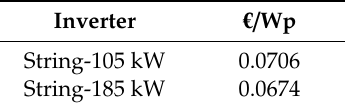
Table A2. String inverters